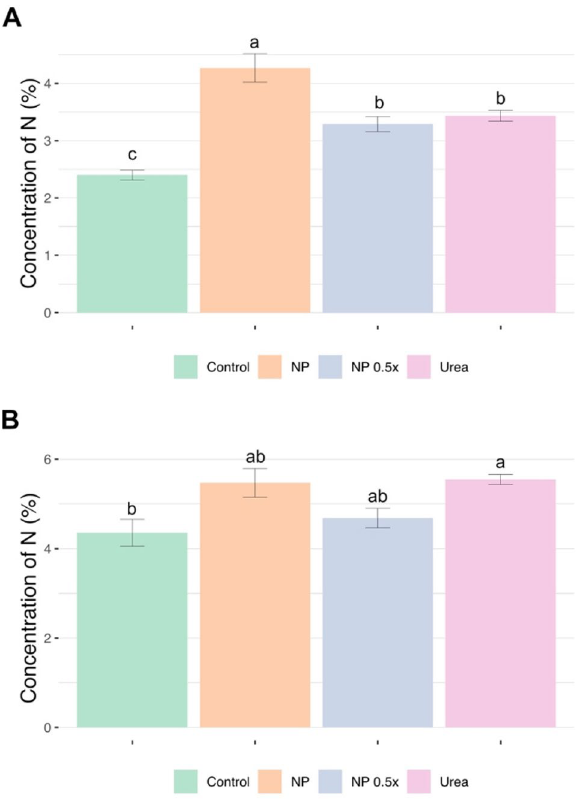
Figure 5. Total N concentration determined in roots ( a ) and shoots ( b ) of cucumber plants at 7 days after the treatments. Statistical analysis has been carried out as specified in Fig.